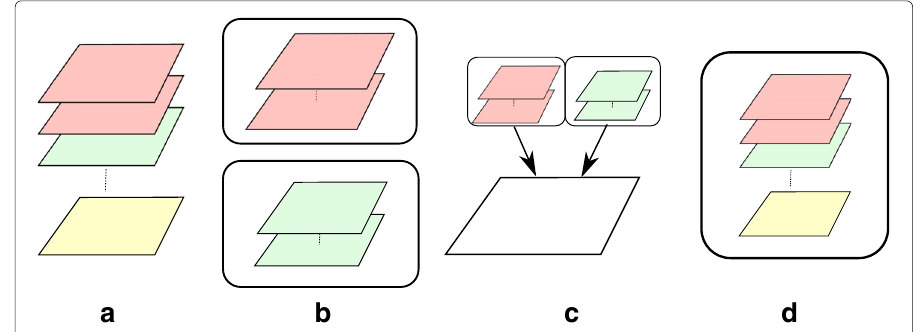
Fig. 2 Individual emotion-annotated layers and the corresponding derived layers used in our analyses (green = positive emotion layers, red = negative emotion layers, yellow = surprise). a Individual layers b Aggregated valence layers c Valence interlayer d Aggregated